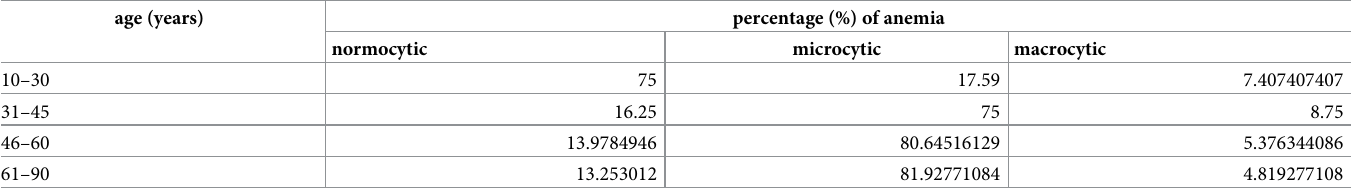
Table 3. Prevalence of normocytic, microcytic and macrocytic by age.